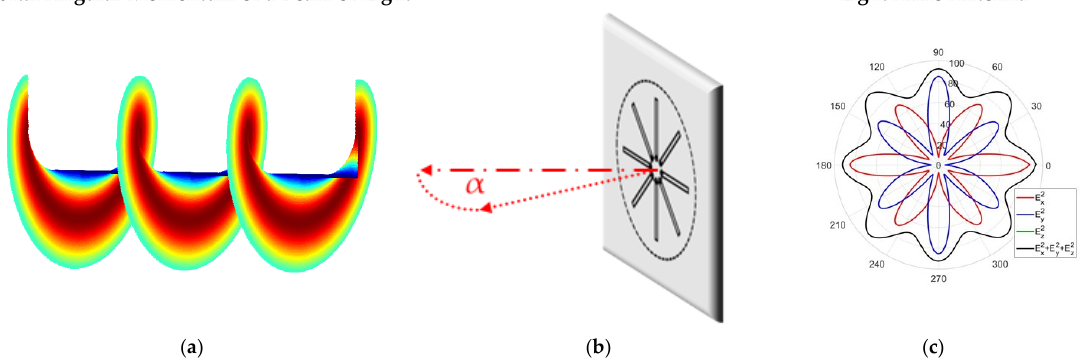
Figure 1. ( a ) Spatially structured field with an orbital angular momentum (OAM) of a beam of light. ( b ) Antenna geometry and antenna plane angle ( α ) relative to the electromagnetic wave propagation direction. ( c ) Antenna electric field squared at normal incidence. Due to the symmetry in normal incidence, E z is approximately